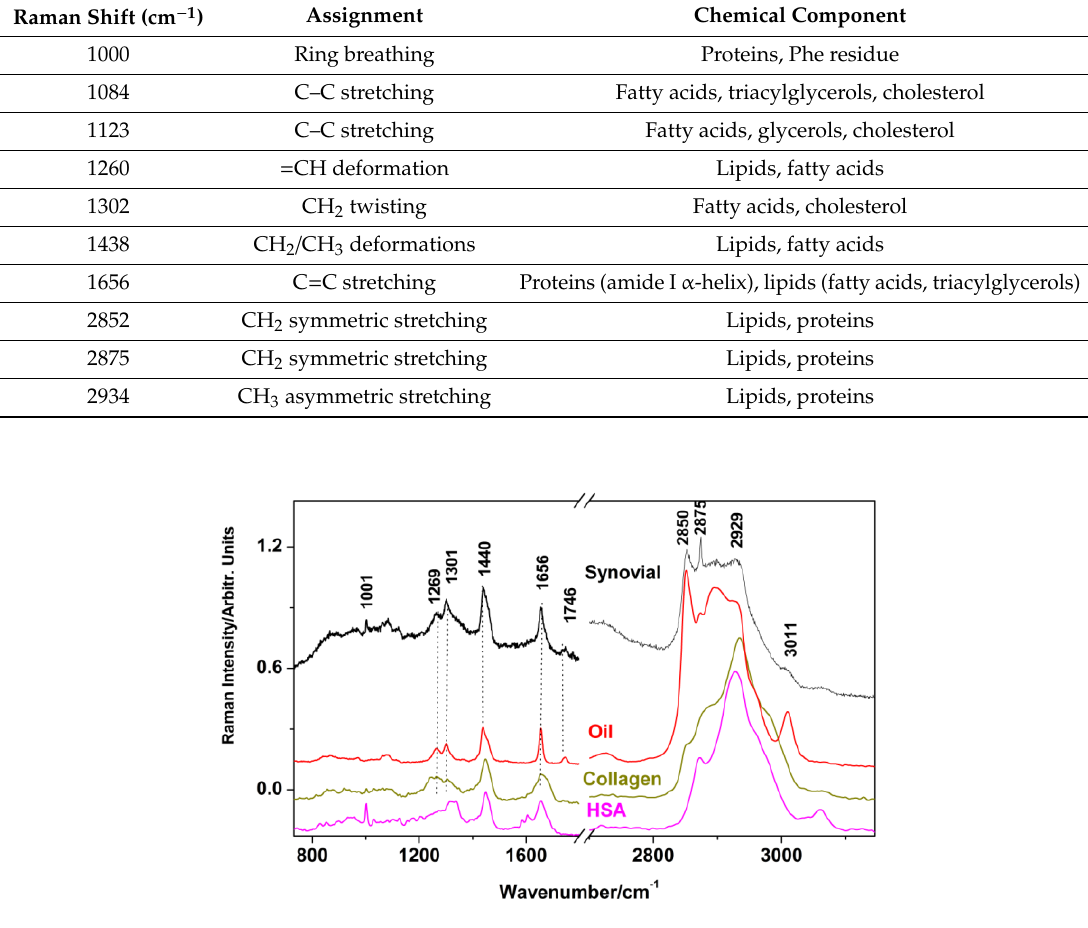
Figure 10. Raw Raman signal of synovial fluid (averaged of 10) compared to the spectra of human serum albumin (HSA) (powder), collagen (powder) and commercial lipid (oil), demonstrating the dominant lipid profile of collected synovial fluid spectrum with proteins signal influence.